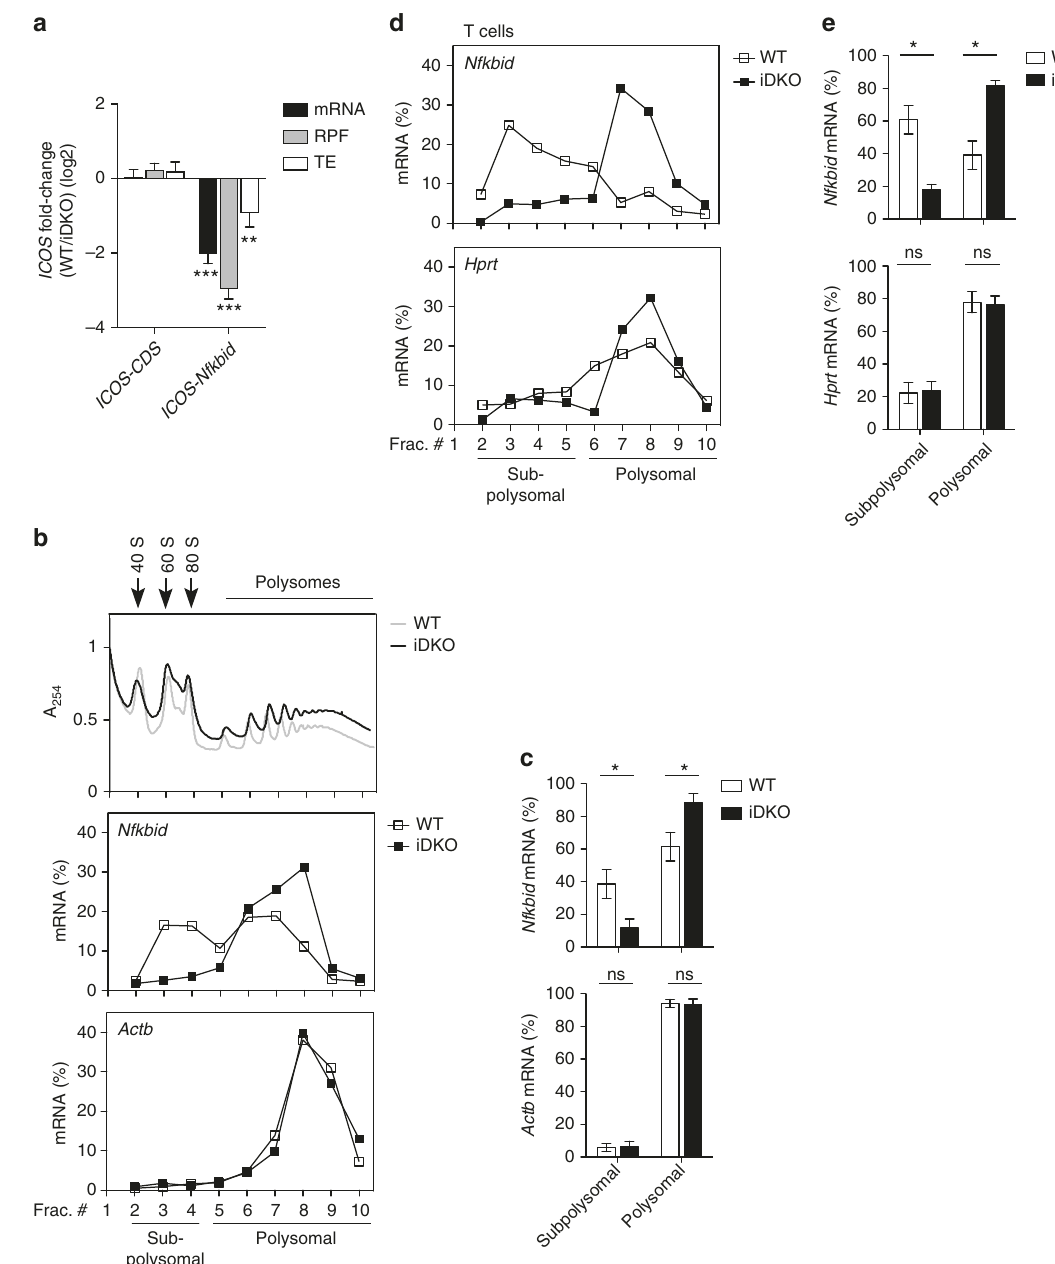
Fig. 6 Roquin inhibits translation of Nfkbid . a mRNA, RPF and translation ef fi ciency (TE) fold-change of ICOS – CDS alone or fused to the 3 ′ -UTR of Nfkbid between untreated (WT) and 4 ′ OH-tamoxifen treated (iDKO) MEF cells to induce deletion of Roquin encoding alleles. b , d Representative polysome pro fi les of endogenous Nfkbid , Actb and Hprt , respectively, in Rc3h1-2 fl / fl ; Cre-ERT2 MEF cells ( b ) as well as in Rc3h1 – 2 fl / fl ; Cd4-Cre-ERT2 CD4 + T cells ( d ) treated with (iDKO) or without (WT) 4 ′ OH-tamoxifen. Cytoplasmic lysates from these cells were fractionated on sucrose gradients. The amounts of mRNA in each fraction were analyzed by RT-qPCR and are shown in percent of the sum detected in all fractions. One absorbance pro fi le at 254 nm indicating the position of ribosomal subunits, ribosomes and polysomes for WT and iDKO MEF cells is shown in the top panel in ( b ). c , e The amounts of mRNA of Nfkbid , Actb , and Hprt in subpolysomal and polysomal fractions were determined from the polysome pro fi les as shown in ( b , d ). The subpolysomal and polysomal fractions were speci fi ed by the appropriate absorbance pro fi le at 254 nm. Fractions 2 – 4 ( c ) or 2 – 5 ( e ) were de fi ned as subpolysomal fractions and fractions 5 – 10 ( c ) or 6 – 10 ( e ) as polysomal fractions. The amounts of mRNA from these fractions were pooled and calculated in percent of the sum detected in all fractions. Statistical signi fi cance was determined by Wald test ( a ) and unpaired two-tailed Student ’ s t test ( c , e ); ns = not signi fi cant; * p < 0.05, ** p < 0.01, *** p < 0.001. Error bars indicate mean ± SEM ( a ) or ± SD ( c , d ). Data are representative of three ( a – c ) and two ( d , e